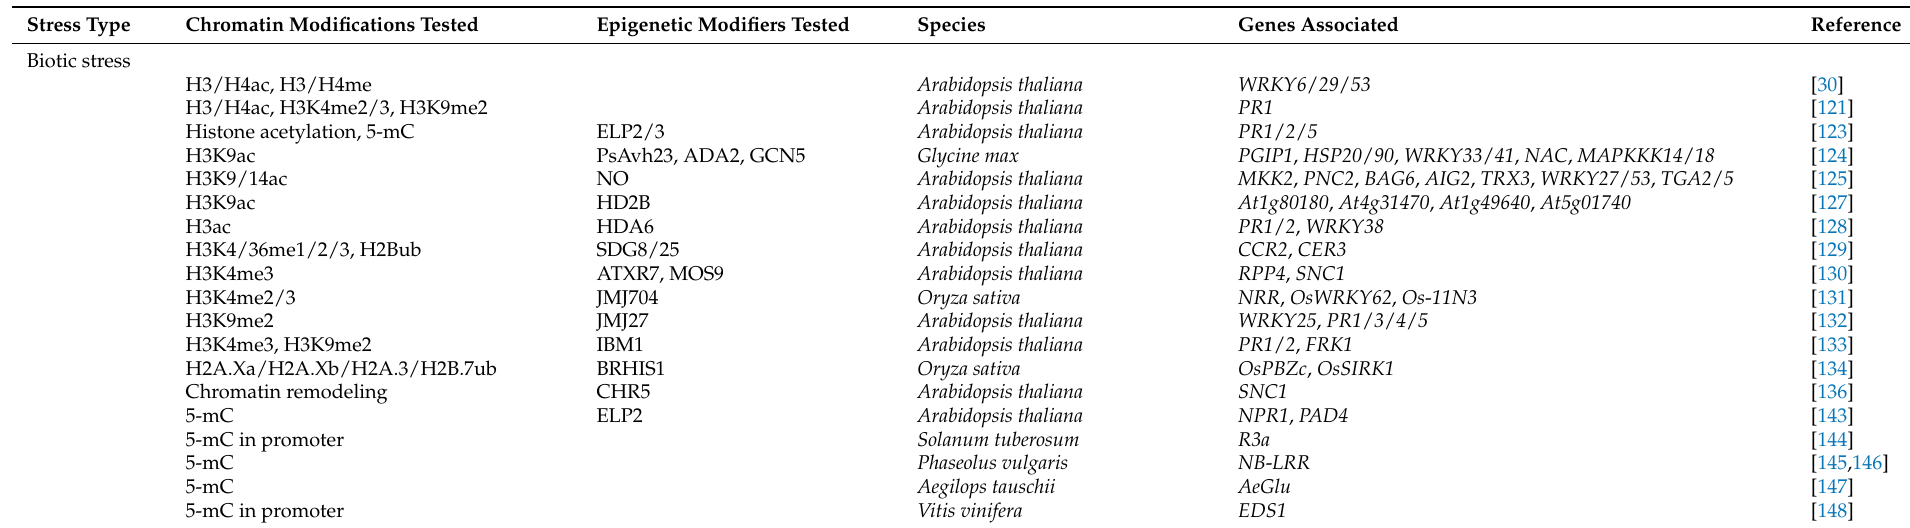
Table 2. Chromatin dynamics (histone modifications and DNA methylation changes) associated with biotic stress-induced gene expression in